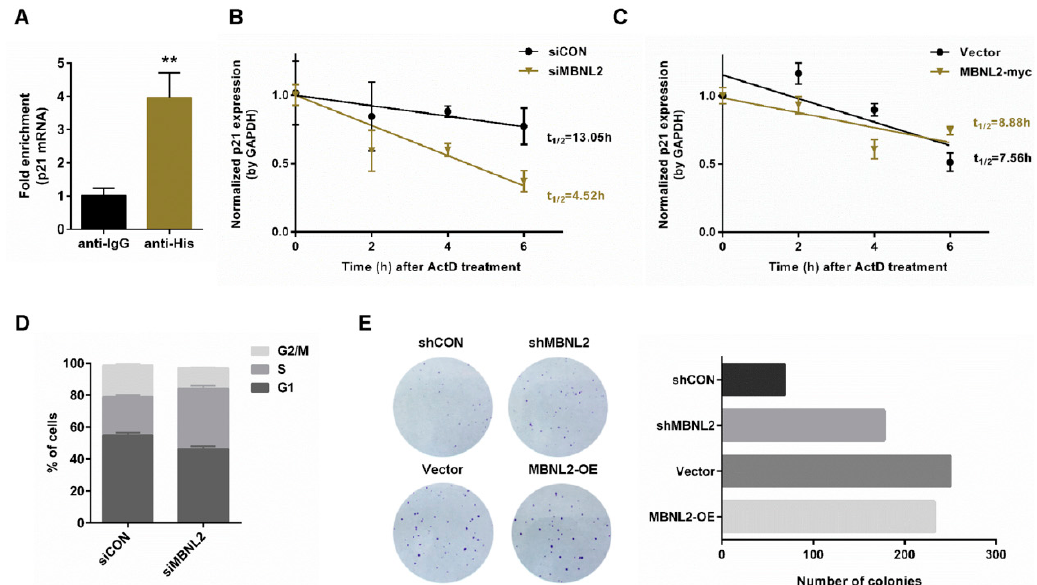
Figure 3. Depletion of MBNL2 destabilizes p21 mRNA and promotes tumor cell proliferation. ( A ) HCT116 cells transfected with His-MBNL2 plasmids were subjected to RIP, and MBNL2-associated p21 mRNA was determined by qRT-PCR. ( B ) HCT116 cells transfected with control or MBNL2 siRNA, ( C ) empty vector, or MBNL2-myc plasmids were treated with 5 mg/mL ActD for the indicated time. Normalized expression (qRT-PCR) of the remaining p21 mRNA after ActD treatment was performed using linear regression analysis. ( D ) Flow cytometry analysis of the percentage for G1, S, and G2/M cells in the HCT116 cells transfected with the indicated siRNAs, pulse-labeled with 1 mg/mL BrdU for 30 min before harvesting, and subjected to PI/anti-BrdU staining. ( E ) Representative images (left) and quantification (right) of the colony formation assay in the HCT116 cells infected with the indicated lentiviral constructs and left for 8-day culture. ** p < 0.01 .